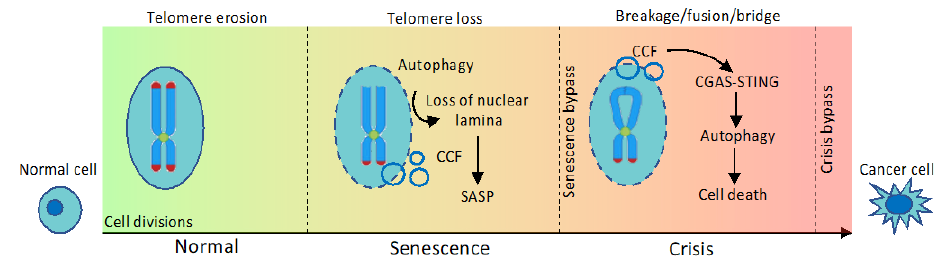
Figure 6. Autophagy acts as a barrier to malignant transformation. Telomeres shorten as a result of cellular replication, leading to replicative senescence. Autophagy promotes senescence through degradation of the nuclear lamina; loss of nuclear lamina leads to extrusion of fragments of chromatin and portions of nucleus, generating CCFs (cytoplasmic chromatin fragments) which are exposed to DNA-sensing pathway, promoting SASP (senescence-associated secretory phenotype). When senescence is bypassed, due to dysfunctional cell cycle check-points, cells continue to divide and could undergo breakage / fusion / bridge cycle, that involves repeated formation of chromosomal fusions and subsequent breaks initiated by the loss of telomere protection. Telomere dysfunction generates CCFs that activate the DNA-sensing CGAS–STING (cyclic GMP-AMP synthase-stimulator of interferon response cGAMP interactor 1) pathway, required for a form of cell death known as replicative crisis, preventing malignant transformation.